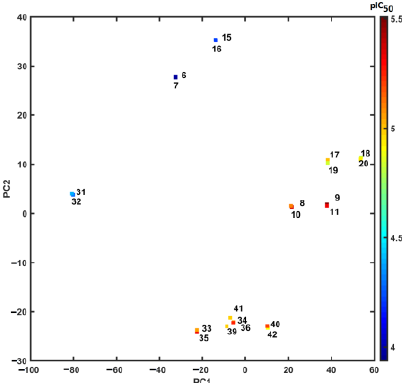
Figure 10. Projection of carborane-containing derivatives on the plane defined by the first vs. second principal component for Dragon descriptors with IC 50 values in the logarithmic scale. Colors code the numerical values of pIC 50 .